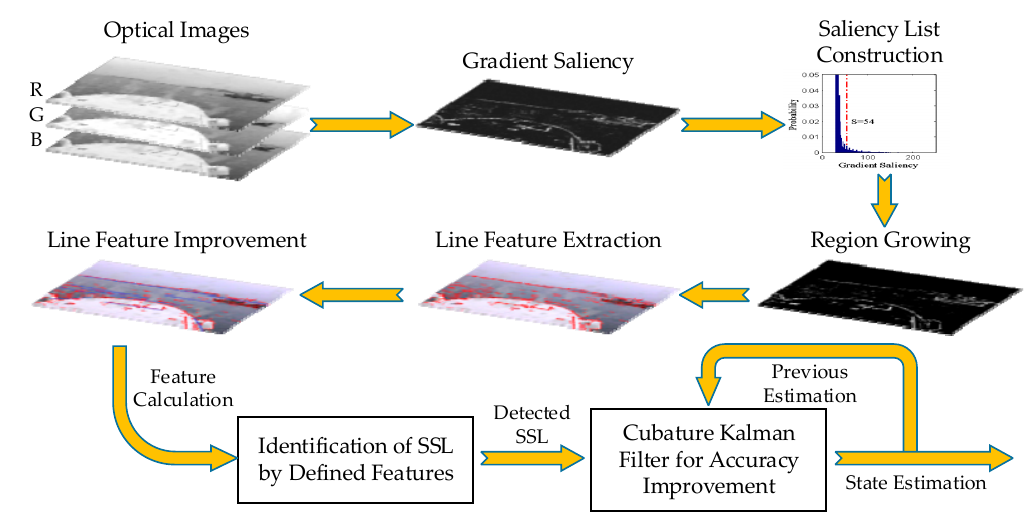
Figure 2. Block diagram of the proposed SSL detection method.